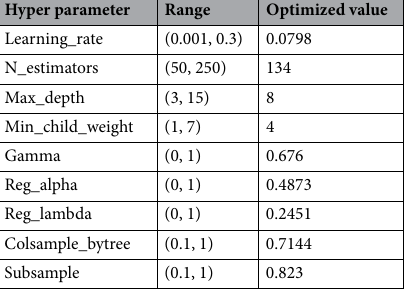
Table 1. Main hyper-parameter range and optimized